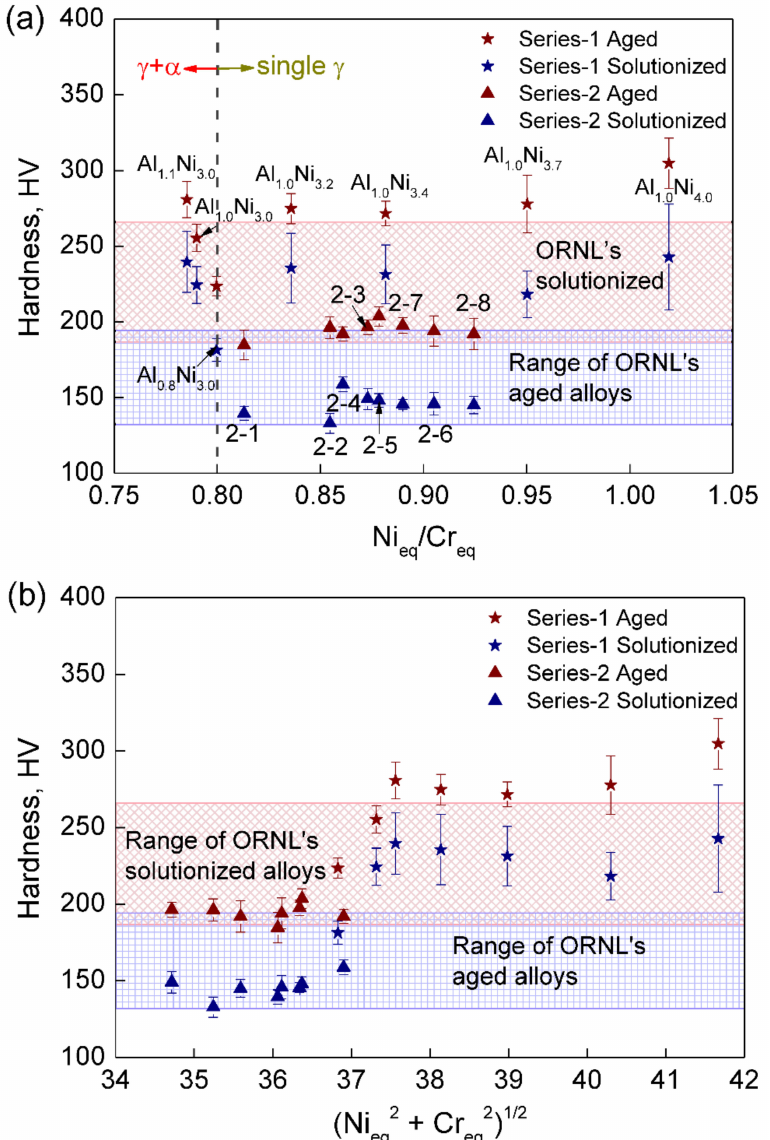
Figure 7. Variations of microhardness HV vs. ( a ) relative austenite stability Ni eq /Cr eq and ( b ) (Ni eq2 + Cr eq2 ) 1/2 which reflects the amount of alloying elements. The shaded regions show the ranges of estimated hardness of Oak Ridge National Laboratory’s (ORNL) alloys calculated based on their tensile results [13,18,23] according to the conversion equations between the hardness and tensile strength of austenitic stainless steels